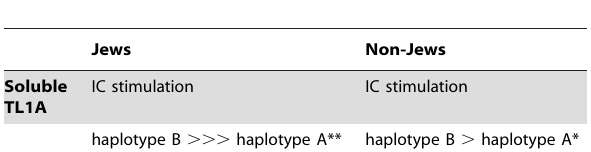
Table 2. Summary of significant differences for TL1A haplotypes A and B in CD patients stratified into Jewish and Non-Jewish